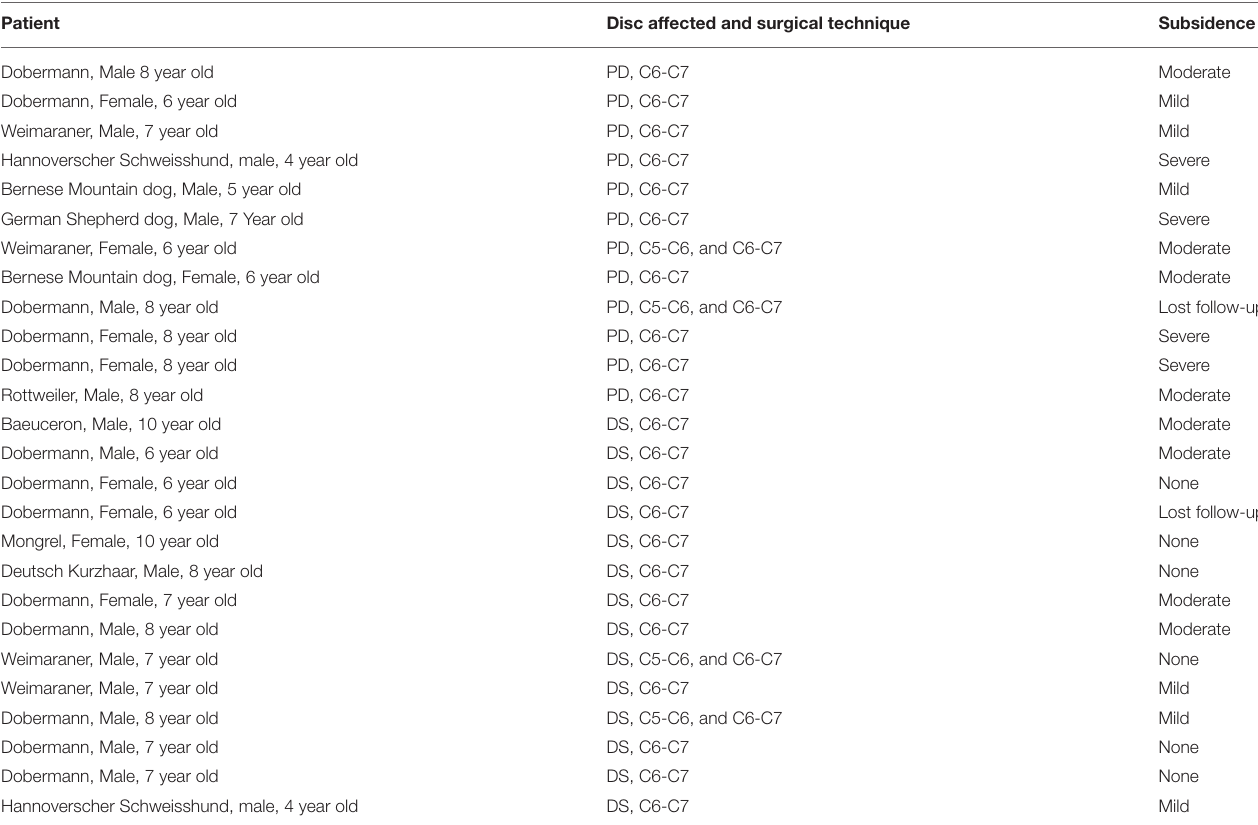
TABLE 1 | Dog’s signalment, intervertebral disc space affected, and the surgical technique applied, PD (prosthetic disc) vs. DS (distraction-Stabilization); Degree of subsidence is also illustrated: none (between 0 and 10%), mild (below 25%), moderate (between 25 and 50%), and severe (more than 50%). Patient Disc affected and surgical